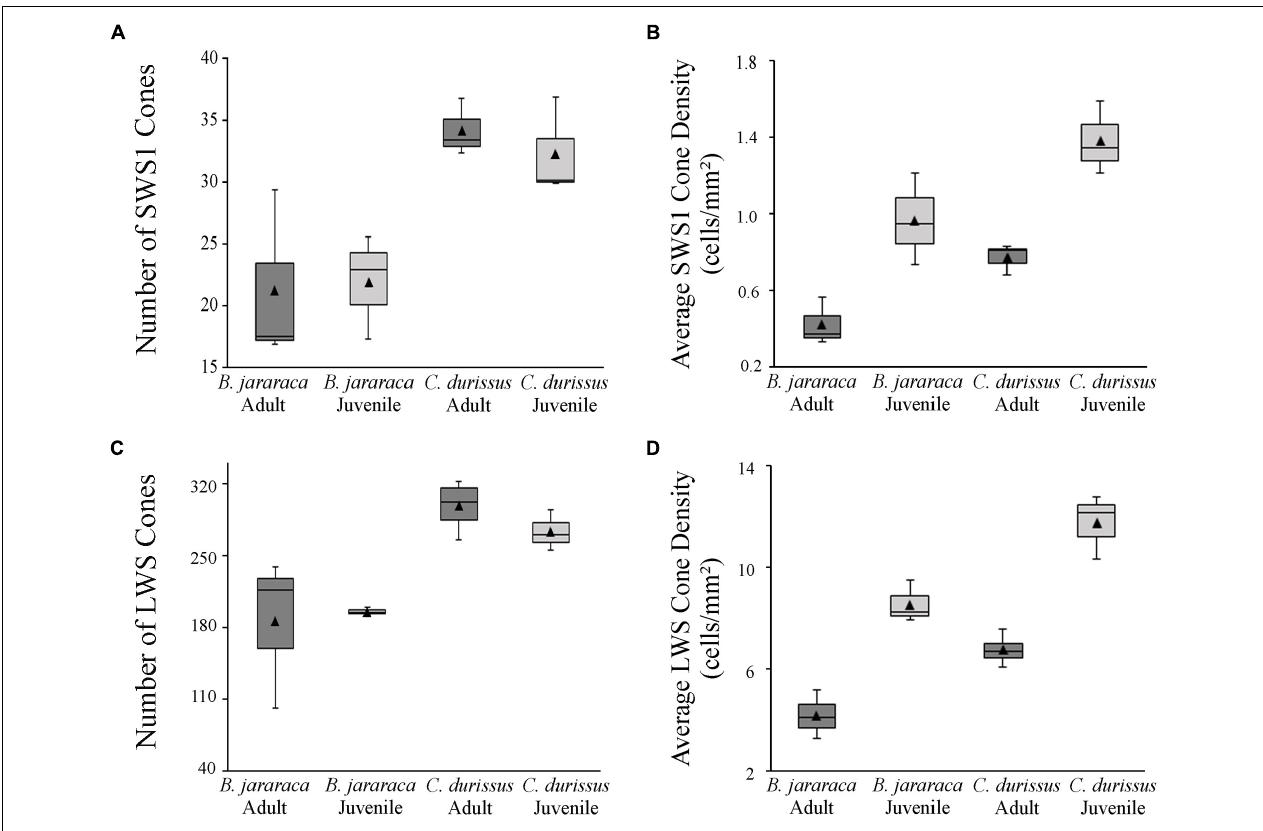
FIGURE 6 | Boxplot representations of the medians (thick black lines) and quartiles (boxes) of the total number and mean density of (A,B) small single SWS1 cones and (C,D) large single and double LWS cones, in retinas of adults and juveniles of B. jararaca and C. durissus . The mean density values are represented by the triangles. The values should be multiplied by 10 3